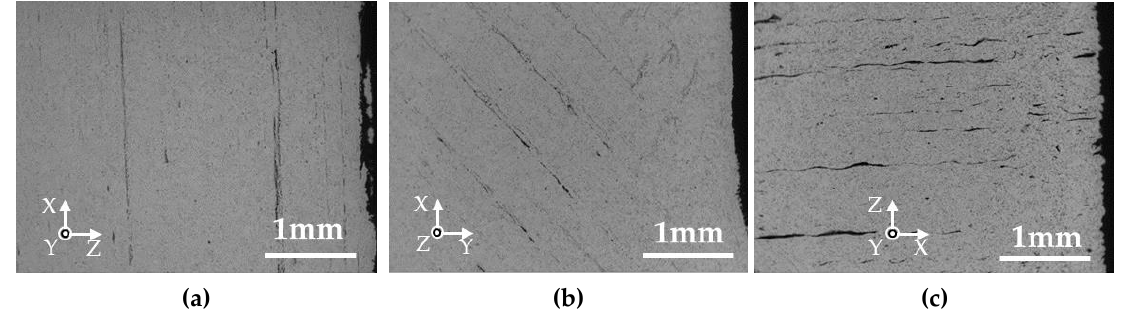
Figure 10. SEM micrographs of cross-sections perpendicular to the thickness of the silver parts printed in a layer thickness of 0.1 mm. ( a ) W-specimen; ( b ) T-specimen; ( c ) L-specimen.